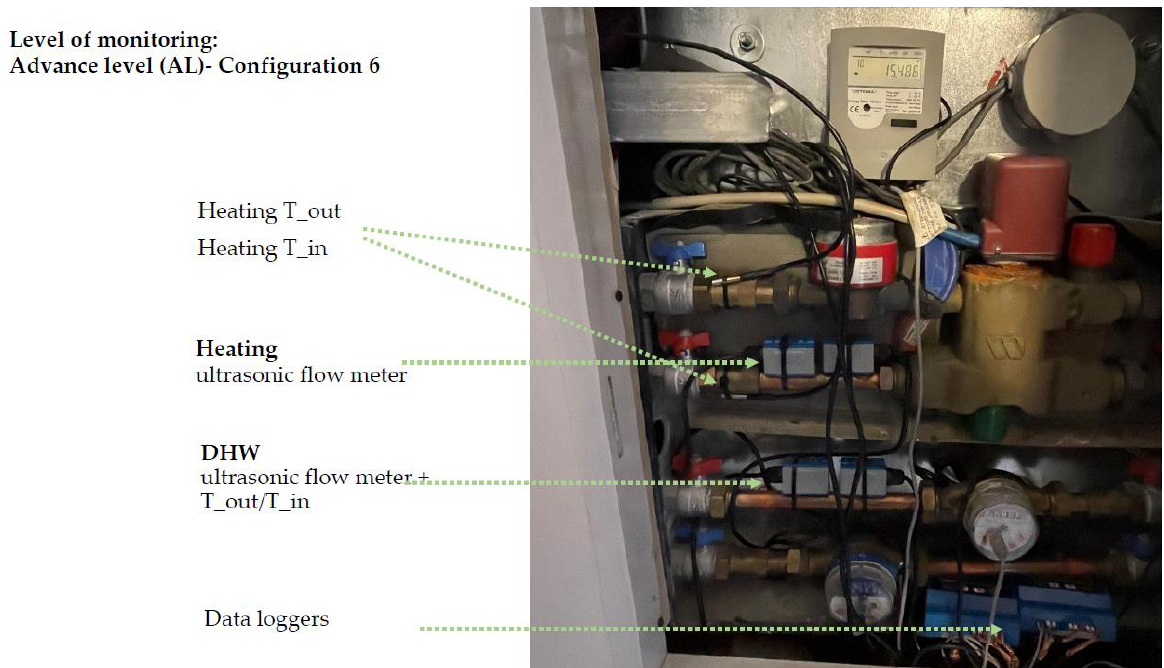
Figure 8. EPCRecast Long Term Monitoring pilot building n°73. Plug and play sensors for thermal energy monitoring according to the configuration 6 (Advanced Monitoring).